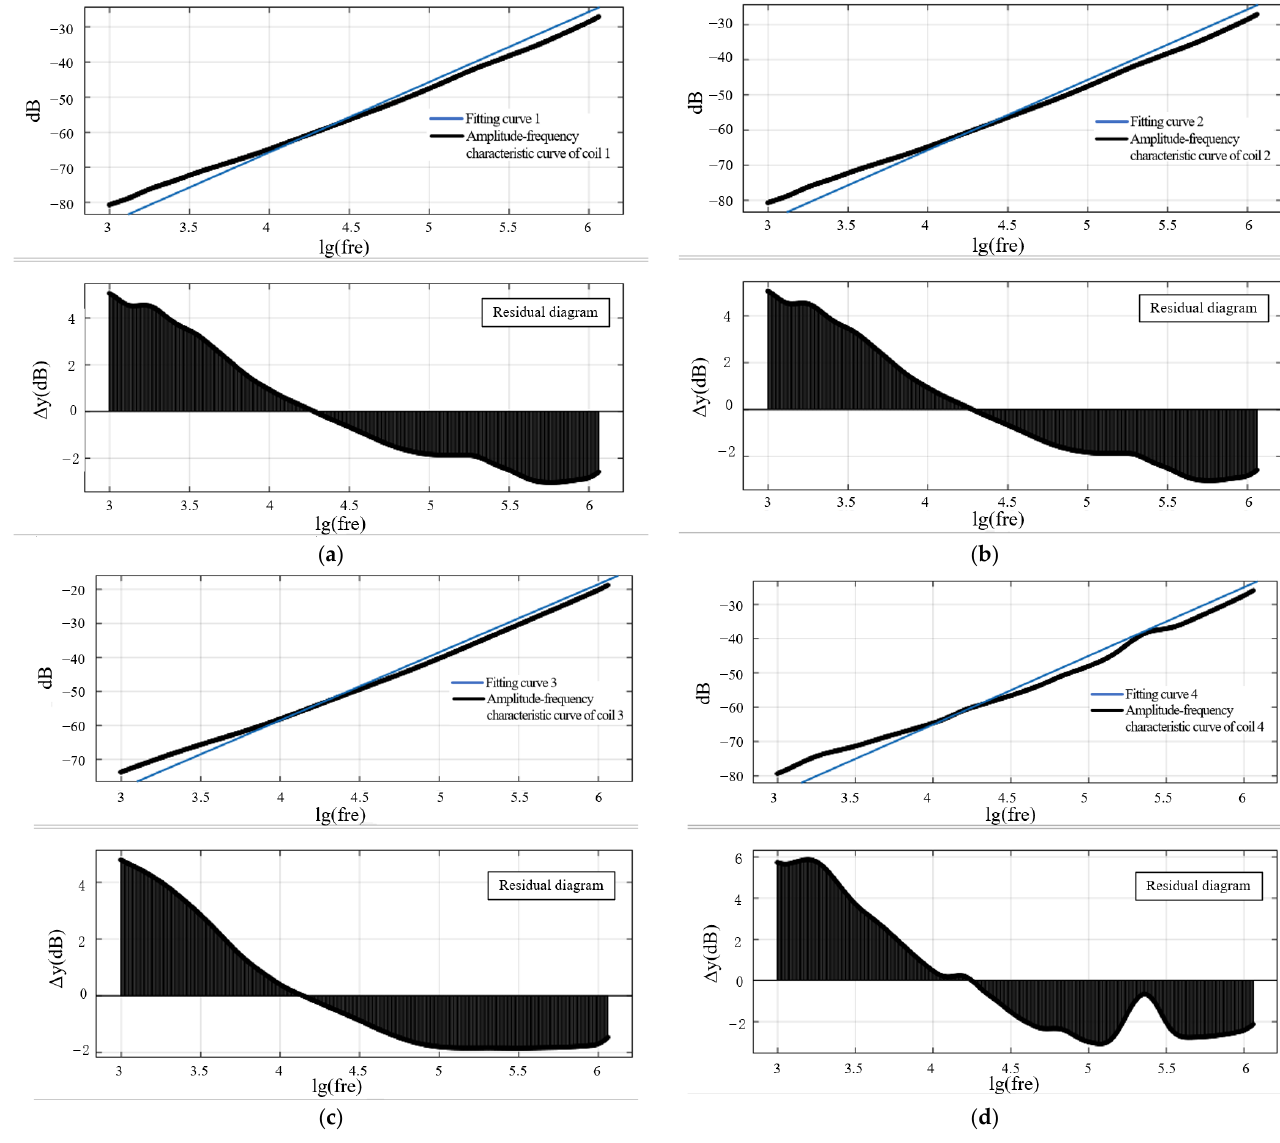
Figure 13. Curve fitting and residual diagram of mutual inductance coefficient of coil 1–4 ( a ) Coil 1. ( b ) Coil 2. ( c ) Coil 3. ( d ) Coil 4. Table 3. Comparison between measured mutual inductance and theoretical values of coils